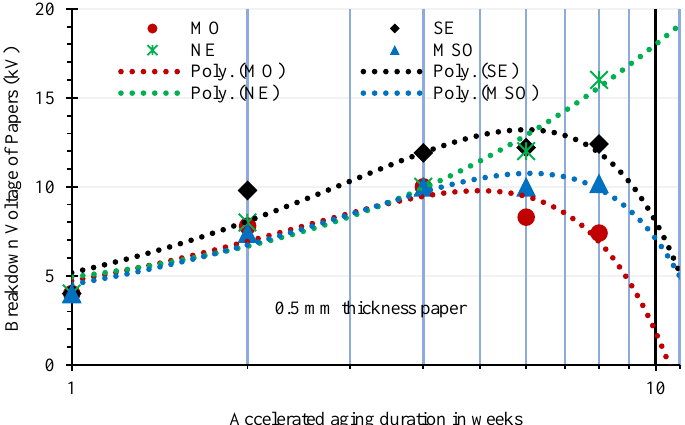
Figure 13. Expectance of BDV for 0.5 mm thickness paper with the diffusion of various insulating oils with thermal stressing.